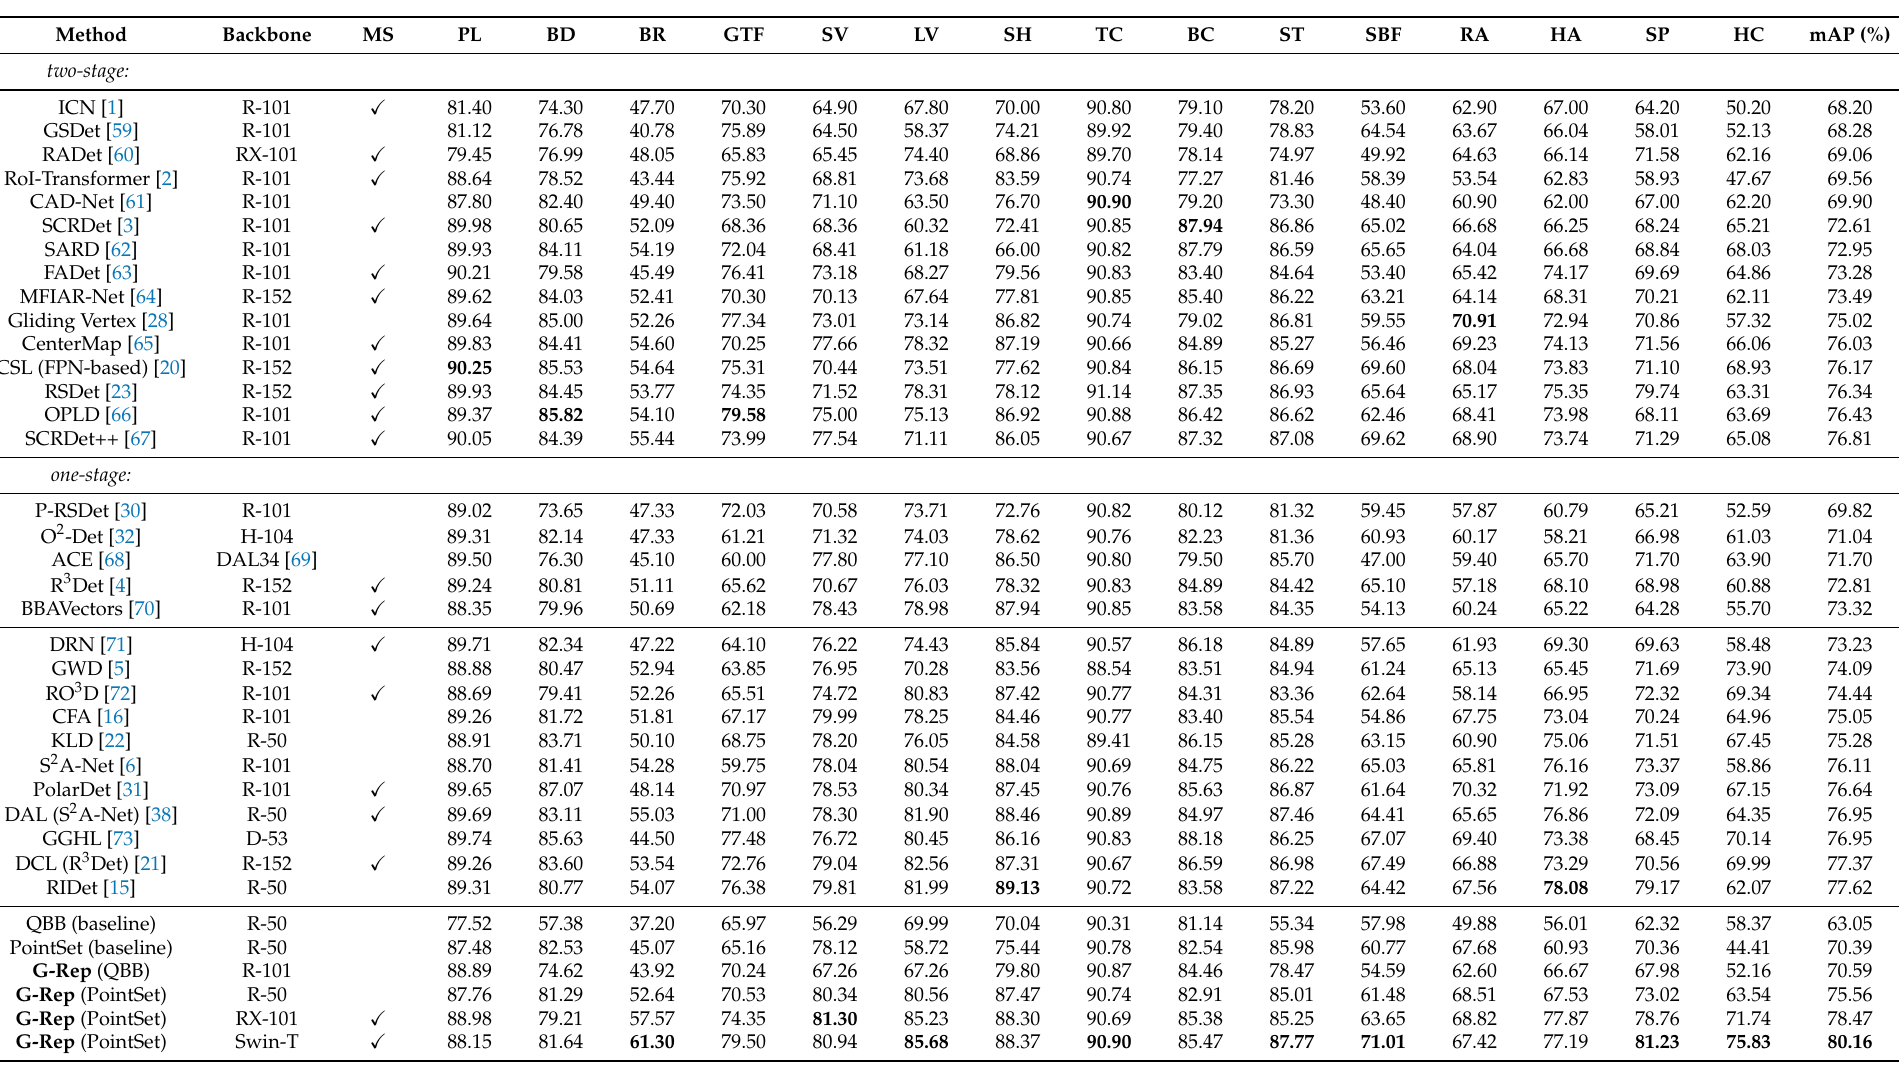
Table 7. Comparison of various detectors of mAP values on the OBB-based task of the DOTA-v1.0. “MS” indicates multi-scale training.